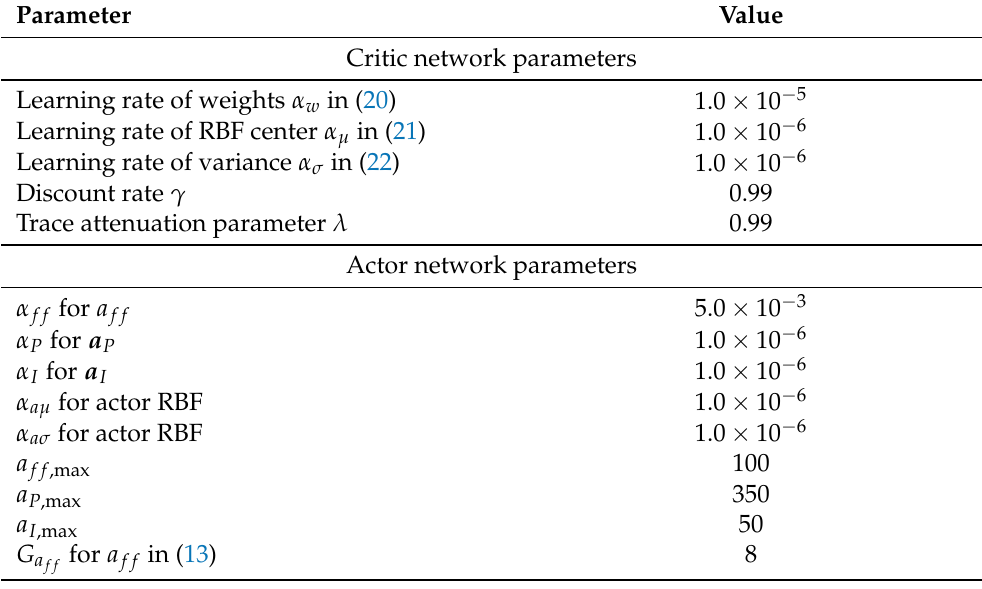
Table 2. Parameters used to formulate actor and critic networks for self-tuning the two-DOF PI control system.